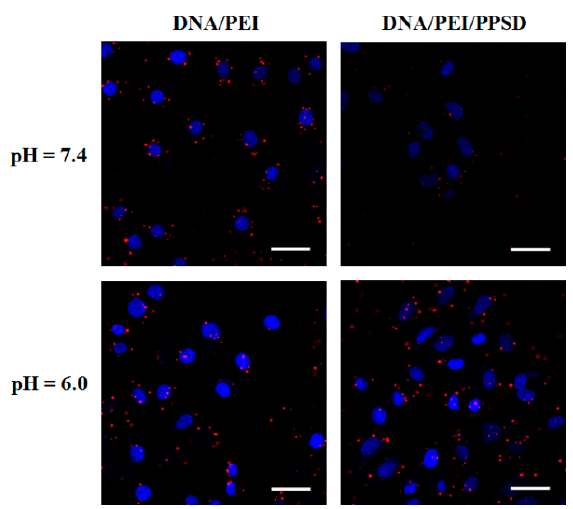
Figure 7. CLSM images of HeLa cells incubated with DNA/PEI ( wt / wt = 1:1) or DNA/PEI/PPSD ( wt / wt / wt = 1:1:32) at pH 7.4 or 6.0. DAPI, cell nucleus (blue); CY5-pDNA (red). Scale bars = 20 μ m.